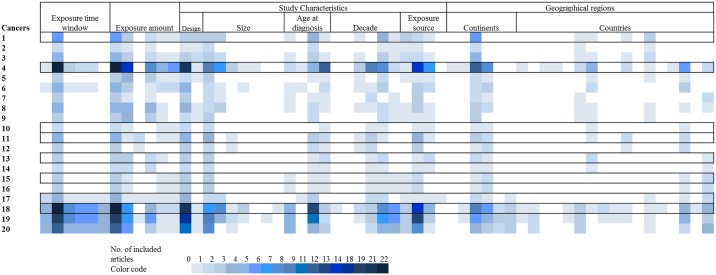
Planned subgroup analyses and number of identified articles for each analysis.Each row corresponds to one cancer (sub)type as listed in Fig 2. For column definition see Table 1.